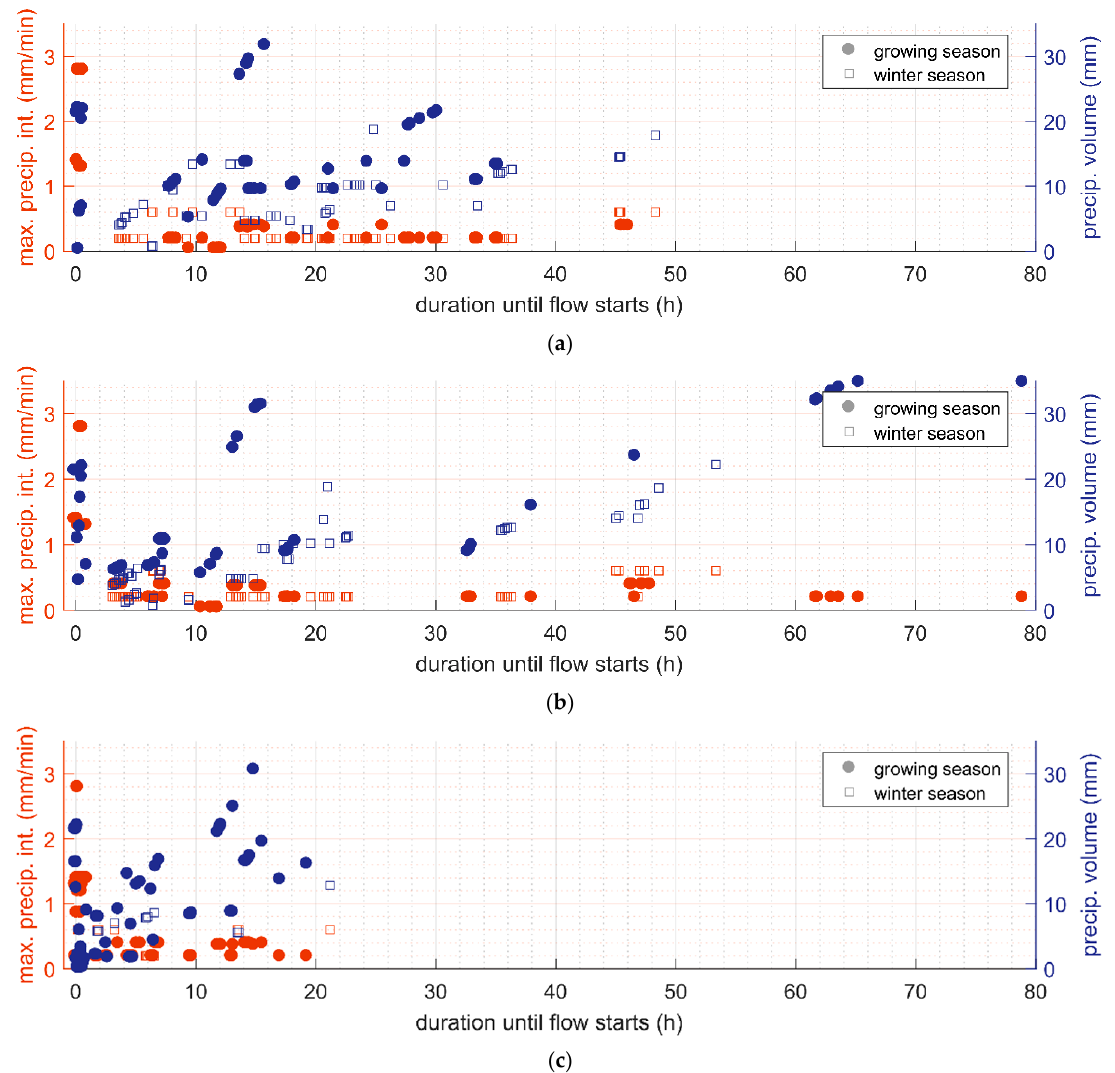
Figure 11. Dependency of response times on precipitation volumes and maximum precipitation until the occurrence of subsurface flow; (a) cropland; (b) grassland; (c) forest.